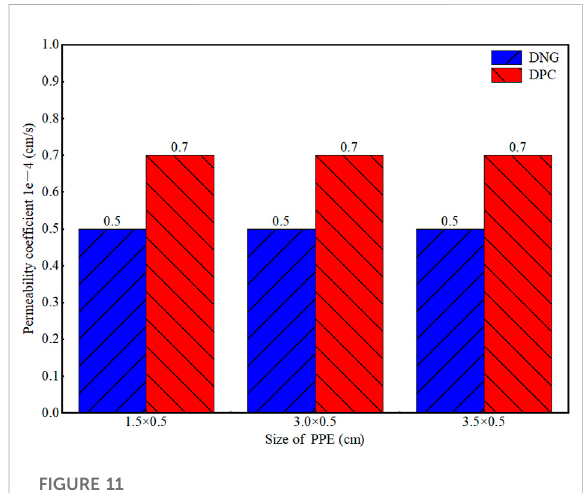
FIGURE 11 In fl uence of PPE of different sizes on permeability coef fi cient of mixed